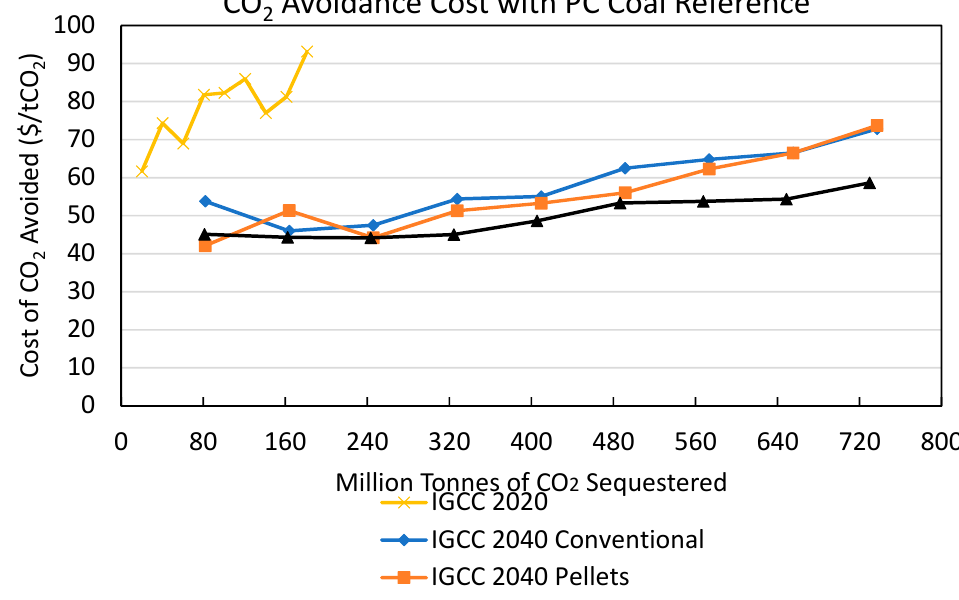
Figure 9. BECCS scenario-average CO 2 avoidance costs (CAC) ($ per tonne CO 2 ) by CO 2 sequestered (million tonnes per year) under the pulverized coal reference scenario, net after supply chain emissions for the four BECCS scenarios: 2020 IGCC conventional, 2040 IGCC conventional, 2040 PC pellets, and 2040 IGCC pellets. “Conventional” refers to biomass handled as chips or bales; “pellets” refers to biomass converted to pellets in process depots.